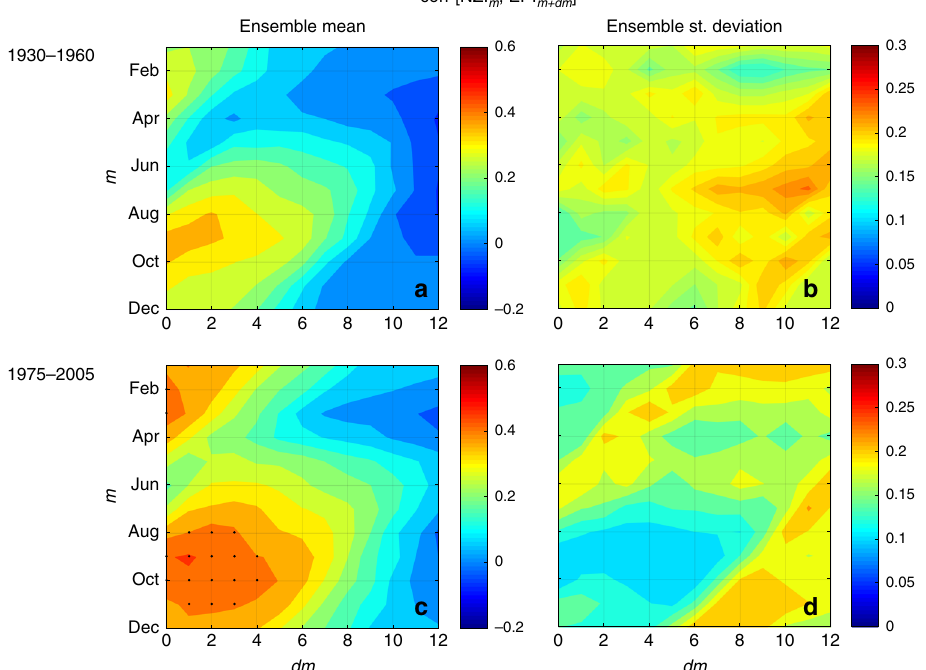
Fig. 2 Changes in the strength of correlation between the NZI and EPI regions derived from the CESM-LENS project. Ensemble mean a , c and ensemble standard deviation b , d of time-lagged correlations between NZI (averaged over the month indicated in the vertical axis) and EPI (lagged forward in time as indicated in the horizontal axis) in 1930 – 1960 a , b and in 1975 – 2005 c , d . Before calculating correlations all series were detrended. Black dots indicate statistical signi fi cance at a = 0.05. A higher level of agreement among ensembles and a clear increase in the NZI-EPI correlations is observed after